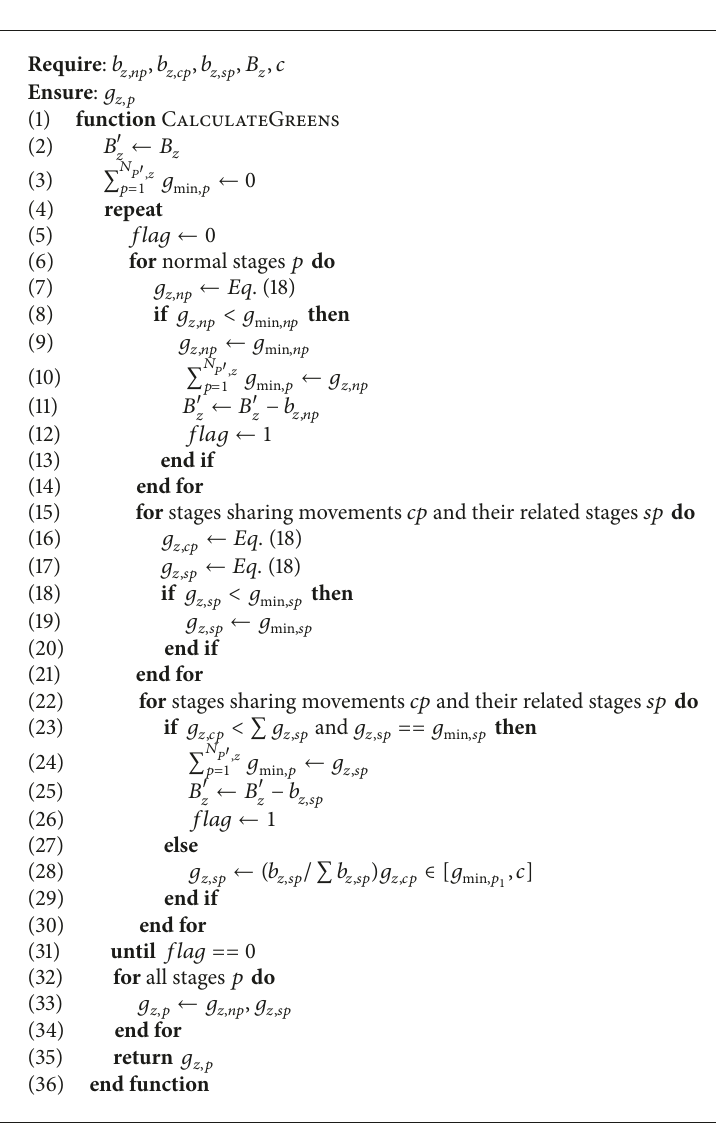
Algorithm 2: Calculation of green duration for each